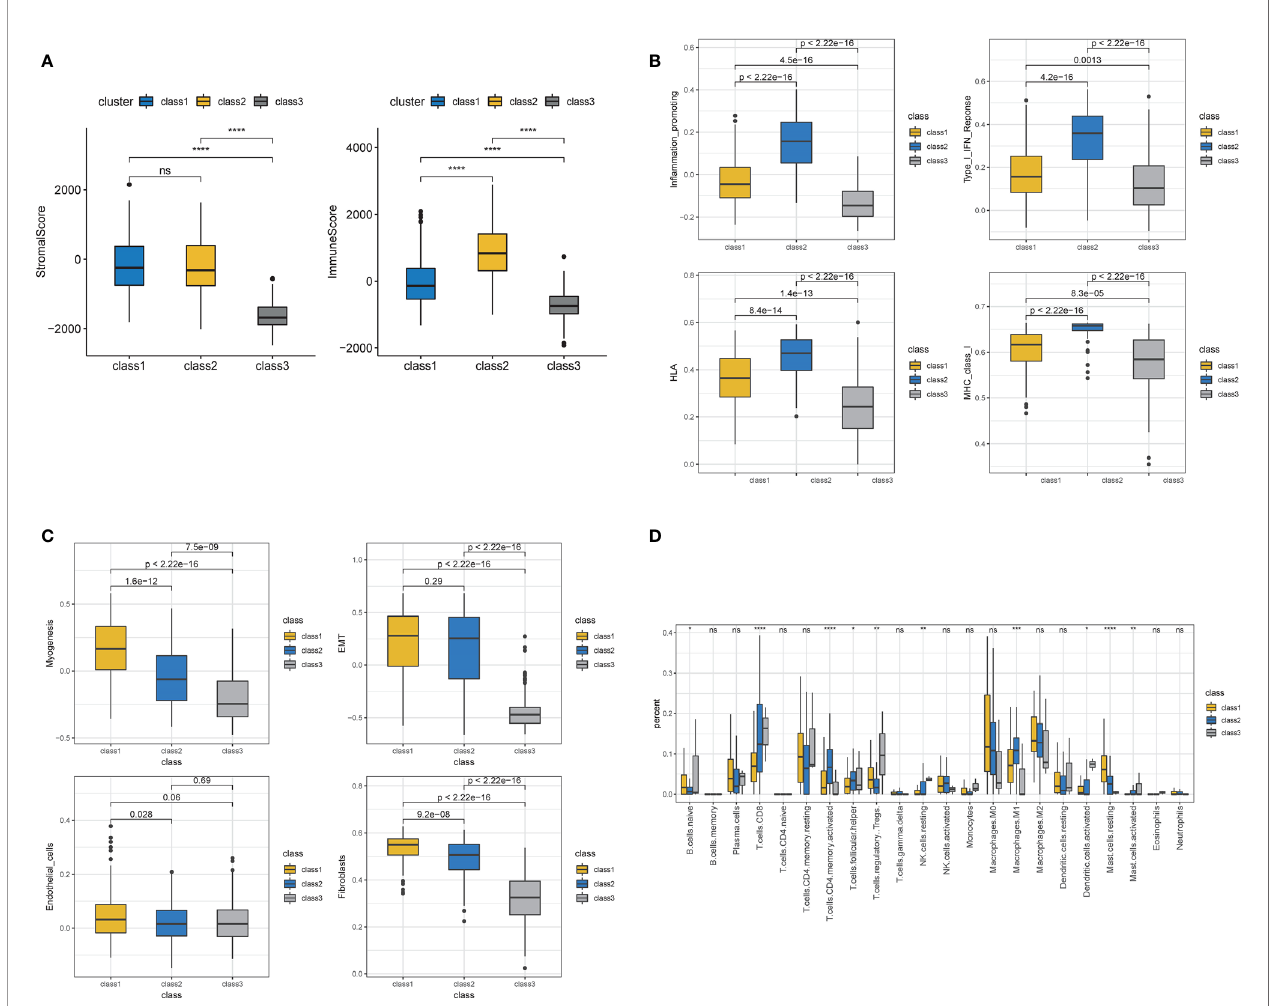
FIGURE 4 | Immune and stromal features of subclasses. (A) Immune and stromal scores among three subclasses. (B) Immune-related molecular biomarkers among the three subclasses. (C) Stromal-related molecular biomarkers among three subclasses. (D) The fractions of 22 immune cells calculated by CIBERSORT among three